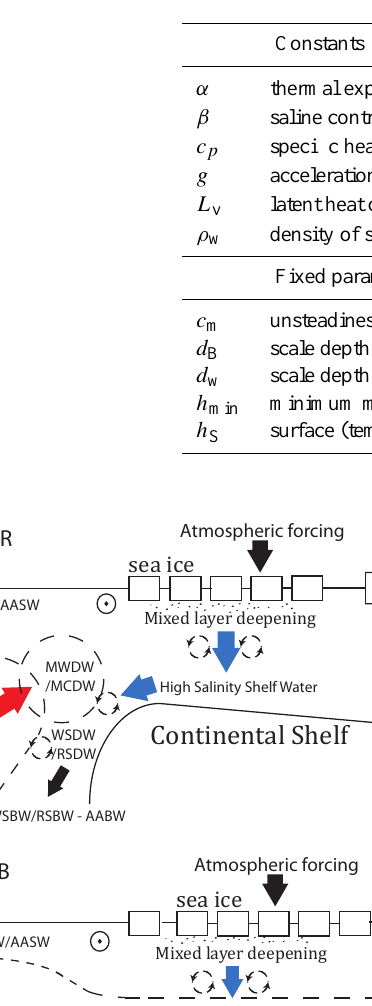
Table 1. Constants and parameters referred to in the model description